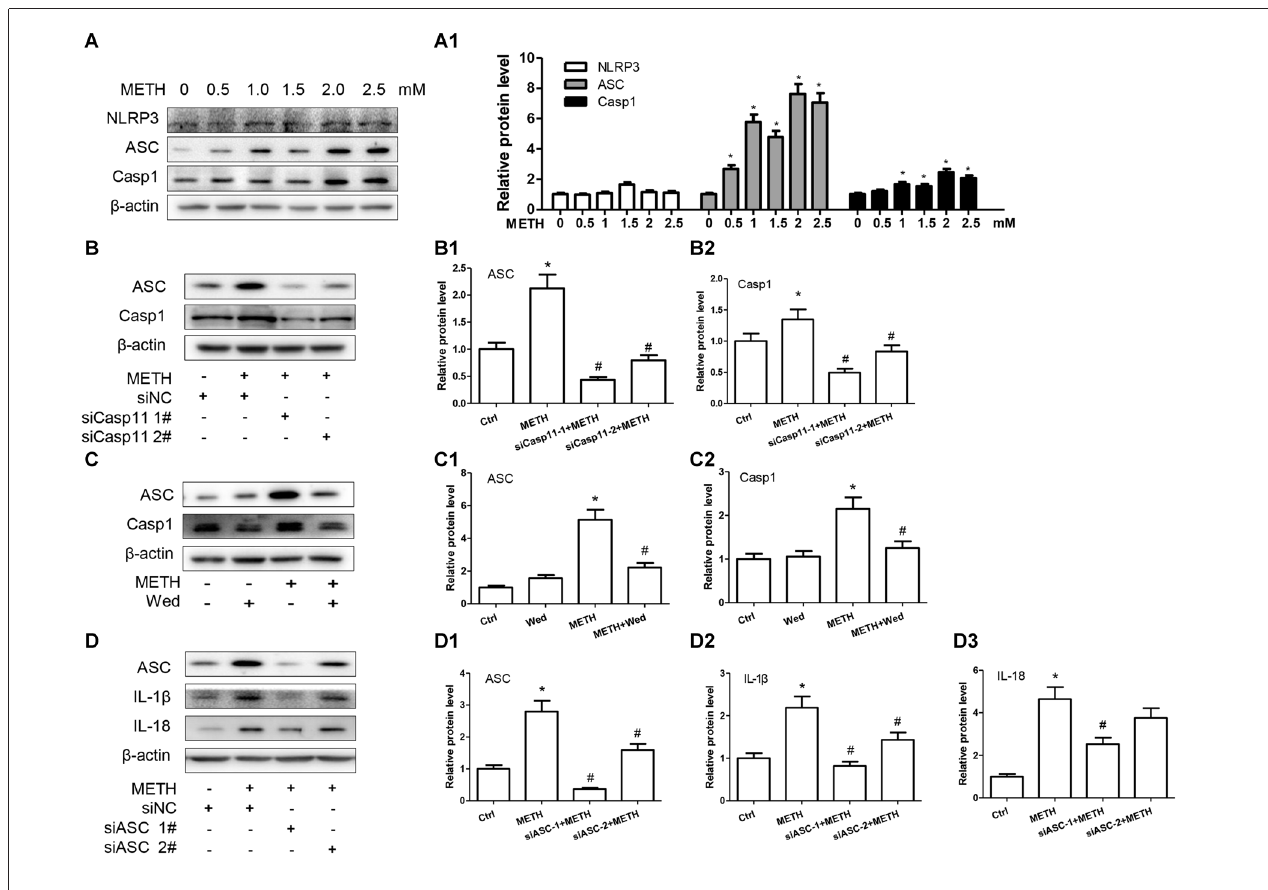
FIGURE 3 | Inflammasomes are involved in Caspase-11-mediated IL-1 β and IL-18 protein expression caused by METH in astrocytes. (A,A1) Primary cultured astrocytes were exposed to 0.5, 1.0, 1.5, 2.0 and 2.5 mM METH for 24 h. (B–B2) Cells were transfected with siRNAs targeting Caspase-11 or control siRNA for 24 h followed by METH (2 mM) treatment for 24 h. (C–C2) Cells were exposed to Wed (30 µ M) for 2 h prior to METH (2 mM) treatment as indicated. (D–D3) Cells were transfected with siRNAs targeting apoptosis-associated speck-like protein containing CARD (ASC) or control siRNA for 24 h followed by METH (2 mM) treatment for 24 h. Western blot (A–D) and quantitative analyses were performed to determine Caspase-11, NLRP3, ASC, Caspase-1, IL-1 β and IL-18 protein expression. All the experiments were repeated three times. Data are expressed as mean ± SD. ∗ p < 0.05 vs. non-METH-treated group. # p < 0.05 vs. the scrambled + METH treated group. Data in (A) were analyzed with one-way ANOVA followed by LSD post hoc analyses; data in (B,D) were analyzed with two-way ANOVA followed by LSD post hoc analyses; data in (C) were analyzed with 2 × 2 factorial ANOVA followed by LSD post hoc analyses.